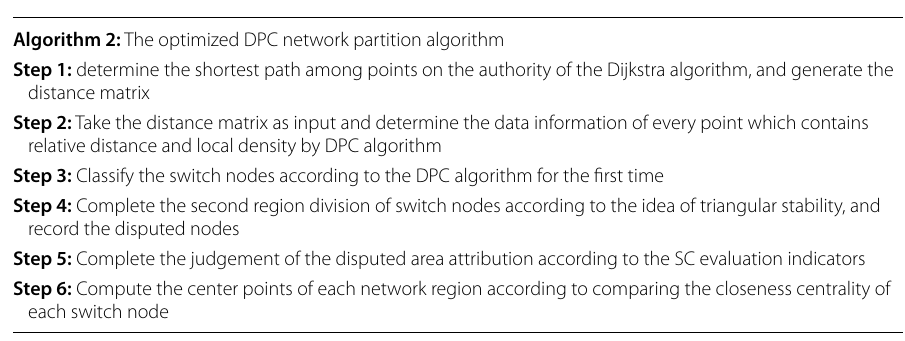
Algorithm 2: The optimized DPC network partition algorithm